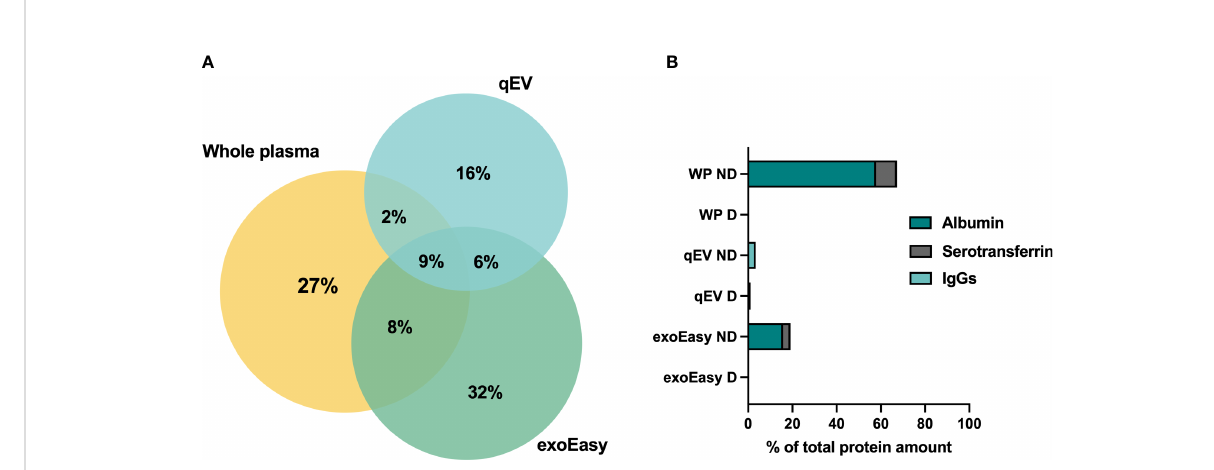
FIGURE 2 Protein overlaps between whole plasma samples and EV-enriched plasma fractions analyzed by LC-MS/MS, and the presence of abundant plasma proteins before and after depletion. (A) Plasma was collected from pre-diabetic female NOD mice. LC-MS/MS analysis was performed on 20 m L of frozen plasma sample or on EVs enriched from 500 m L of frozen plasma by qEV or exoEasy. Venn diagram representing the percentages of shared and unique proteins identi fi ed by MS in whole plasma sample (number of proteins = 298), and EV samples enriched by qEV (n = 215) or exoEasy (number of proteins = 356). (B) Plasma was collected from non-diabetic NOD mice, frozen and pooled before analysis. A whole plasma (WP) sample or EV samples enriched using qEV (n = 2, pooled or separate) or exoEasy (n = 2) were either untreated or subjected to removal of three high-abundance/highly-abundant plasma proteins using the Multiple Af fi nity Removal Spin cartridge mouse-3 column (Agilent Technologies, USA). LC-MS/MS analysis was performed and the percentages of the total protein amount that accounted for albumin, serotransferrin and IgGs in whole plasma (WP), qEV and exoEasy EV samples with (D) and without (ND) depletion is shown (n =1 out of 1-2 for each